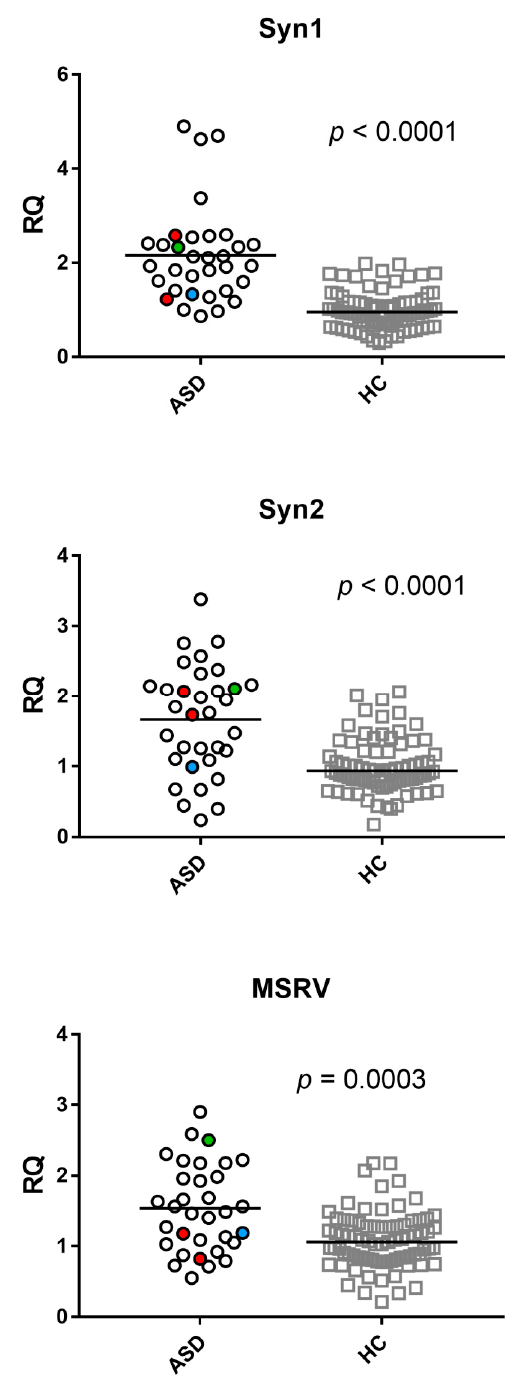
Figure 2. Transcription levels of env genes of SYN1, SYN2, and MSRV in whole blood from 33 children with autism spectrum disorder (ASD) and 79 healthy controls (HC). RQ: relative quantification. Circles and squares show the median of three individual measurements, horizontal lines the median values. Red circles: values of two patients on valproic acid therapy. Green circle: value of the patient on aripiprazole therapy. Blue circle: value of the patient on cyproheptadine therapy. Statistical analysis: Mann–Whitney test was used to compare the transcriptional levels of each target gene between children with ASD and HC.